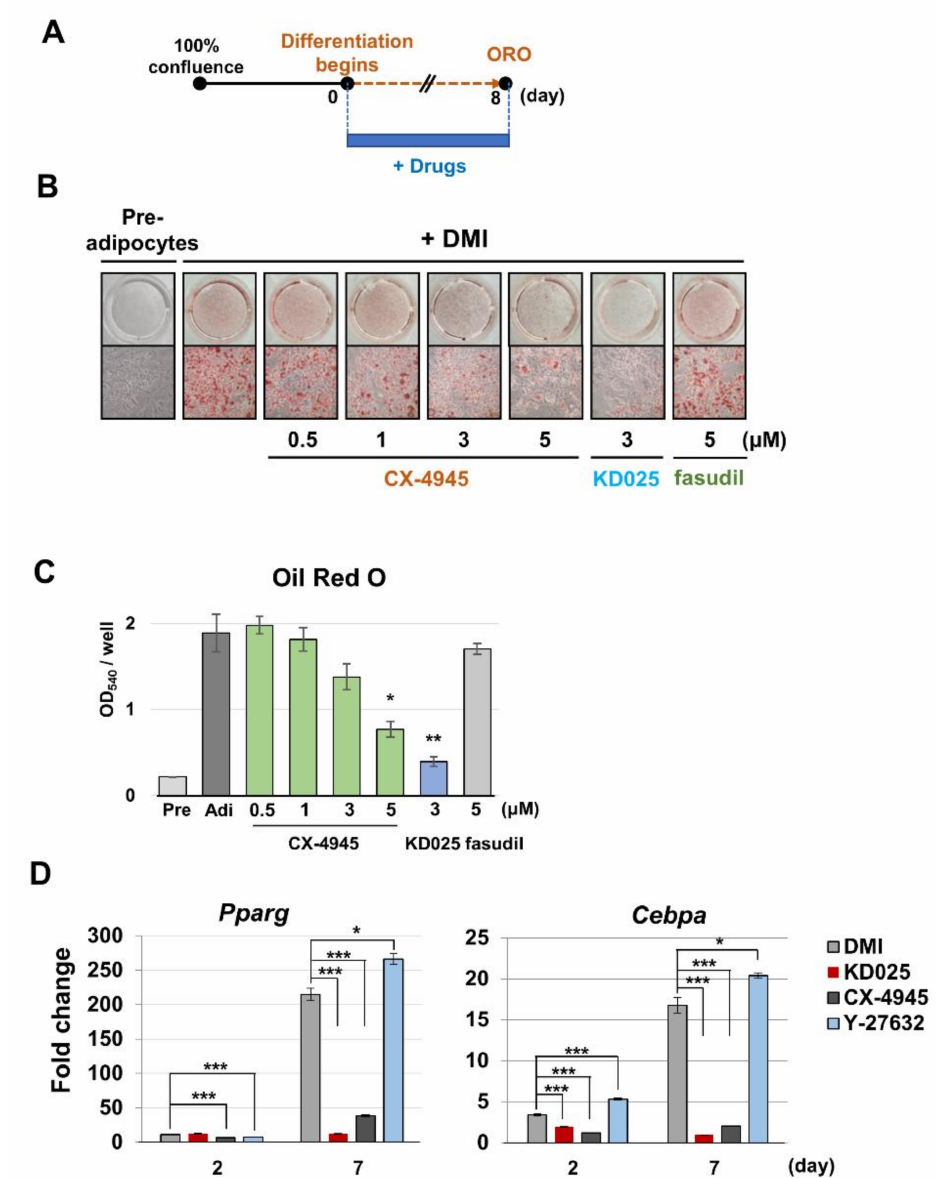
Figure 5. Effect of CX-4945 on adipogenesis in 3T3-L1 cells. 3T3-L1 cells were differentiated by incubating in differentiation media (DMI) with or without CX-4945 at various concentrations. KD025 (3 µ M) and fasudil (5 µ M) were used as positive and negative controls. ( A ) Experimental scheme of differentiation and sample preparation. ( B ) At day 8, cells were stained using ORO and micro- scopic images were taken for ORO-stained cells. ( C ) Lipid accumulation was assessed by obtaining absorbance at 540 nm. ( D ) KD025 (5 µ M), CX-4945 (10 µ M) and Y-27632 (10 µ M) were treated. Total RNA was extracted from the differentiating cells at days 0, 2, and 7. qRT-PCR analysis was performed for adipogenic genes Pparg and Cebpa . The level was calculated by the ∆ Ct method and expressed as fold changes compared with the value of preadipocyte (day 0). * p < 0.05; ** p < 0.01; *** p < 0.005 vs. DMI control at the same